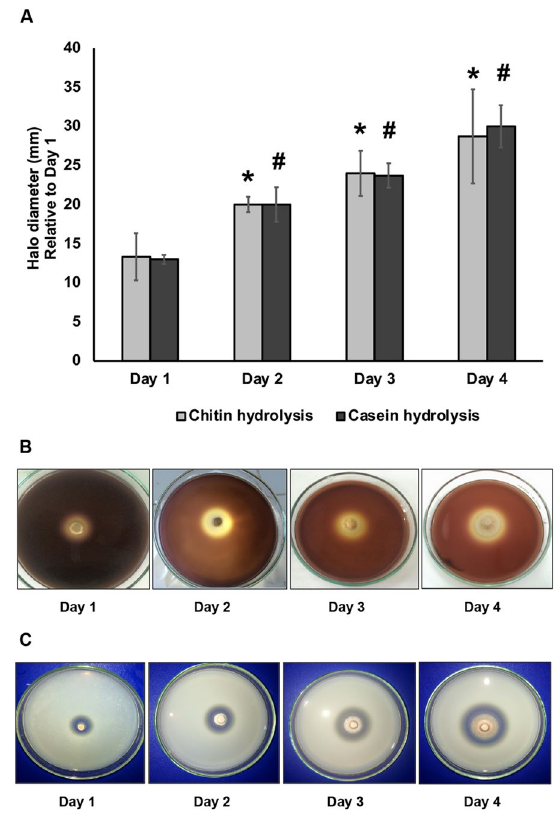
Fig. 2 Chitinase and protease activity of Purpureocillium lilacinum PL1 on agar plate. A Halo diameter of chitin (black) and casein (gray) degradation of P. lilacinum PL1 at different time intervals. B Representative images of the chitin degradation ability of P. lilacinum PL1 on agar plate. C Representative images of the casein degradation ability of P. lilacinum PL1 on agar plate. * or # Indicates statistically significant differences relative to the day 1